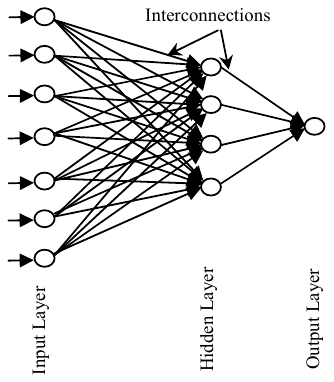
Fig. 1: An Artificial Neural Network for seven input variables, four hidden and one output